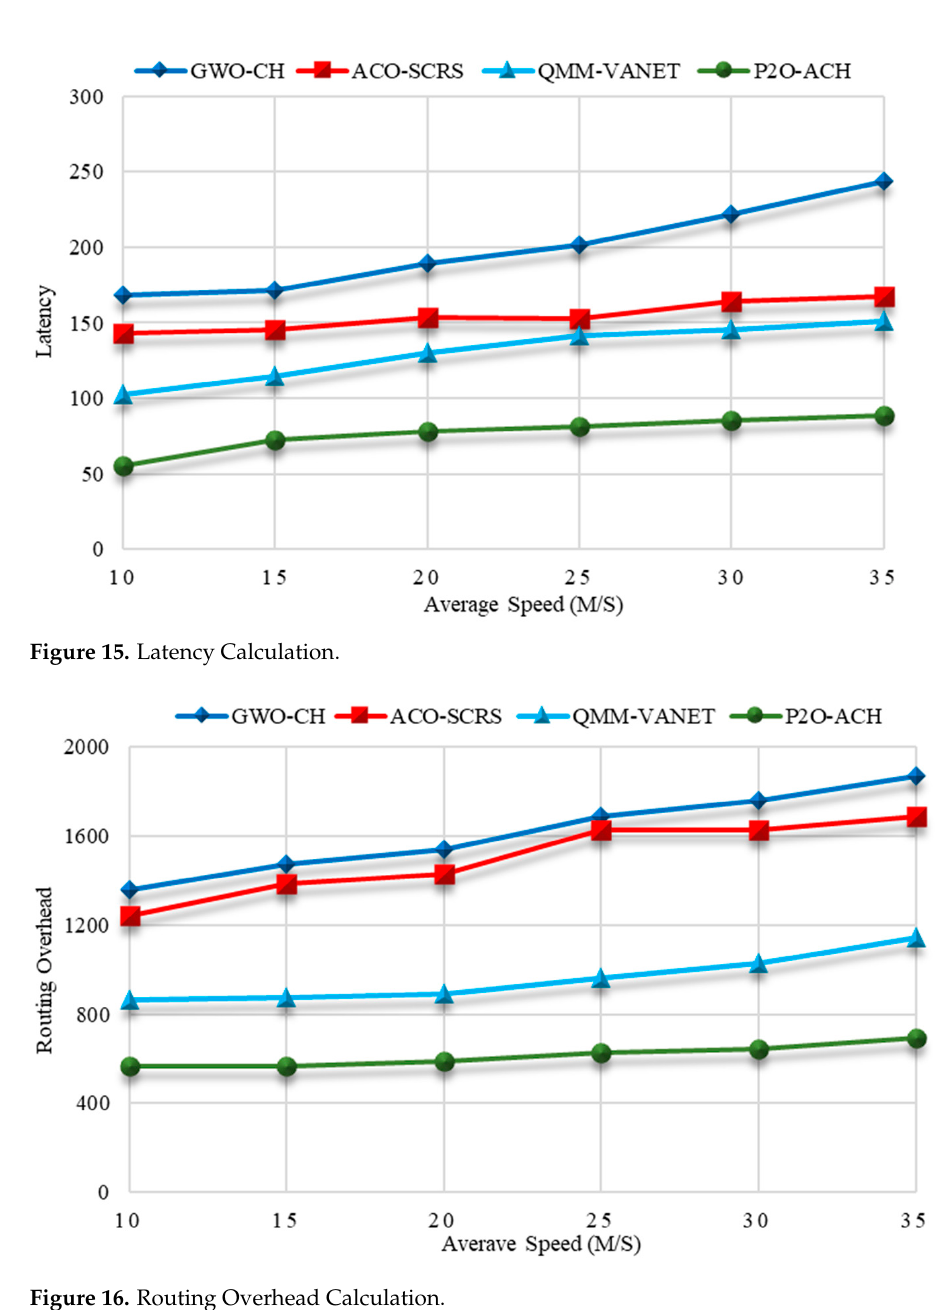
23 of 30 Figure 14. Packet Delivery Ratio Calculation.